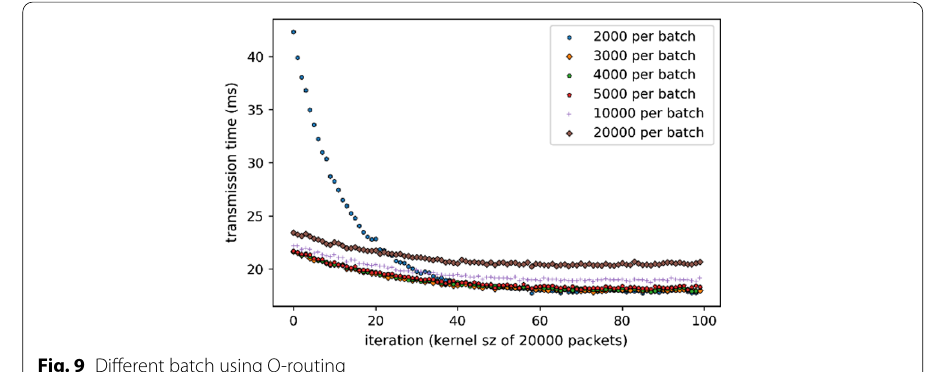
Fig. 9 Different batch using Q-routing